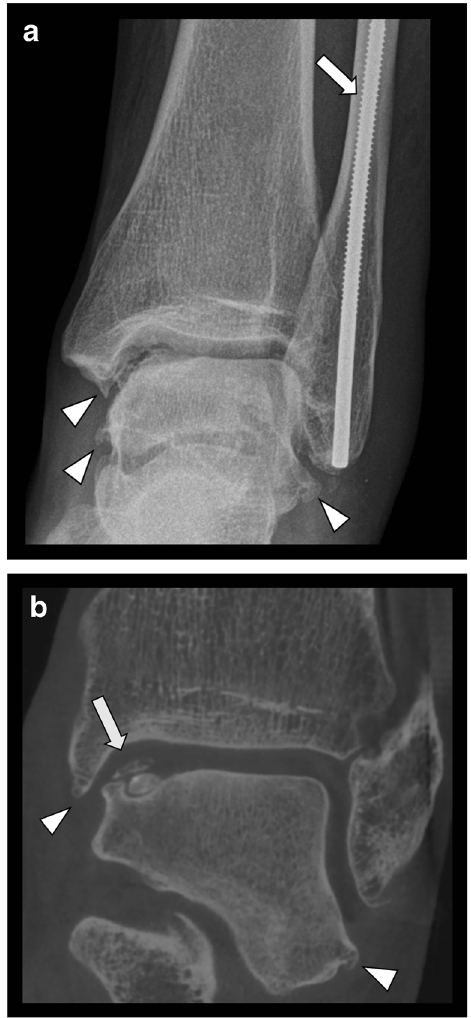
Fig. 9 Posttraumatic unstable osteochondral lesion of the talus and massive degenerative changes of the ankle in a 66-year-old female. a . CR (AP view) demonstrating the presence of metallic screw within the fibula (arrow). Noteirregular articular surface oftalar dome and advanced degenerative changeswith osteophytes formation(arrowheads). b . CBCT coronal reformatted image better shows the presence and extent of an unstable osteochondral lesion (arrow) and osteophytes (arrowheads). There is no metal artifact from the screw in the